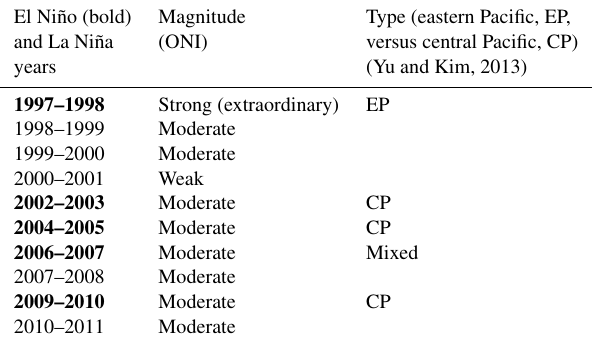
Table 1. El Niño and La Niña years and their characteristics (mag- nitude and